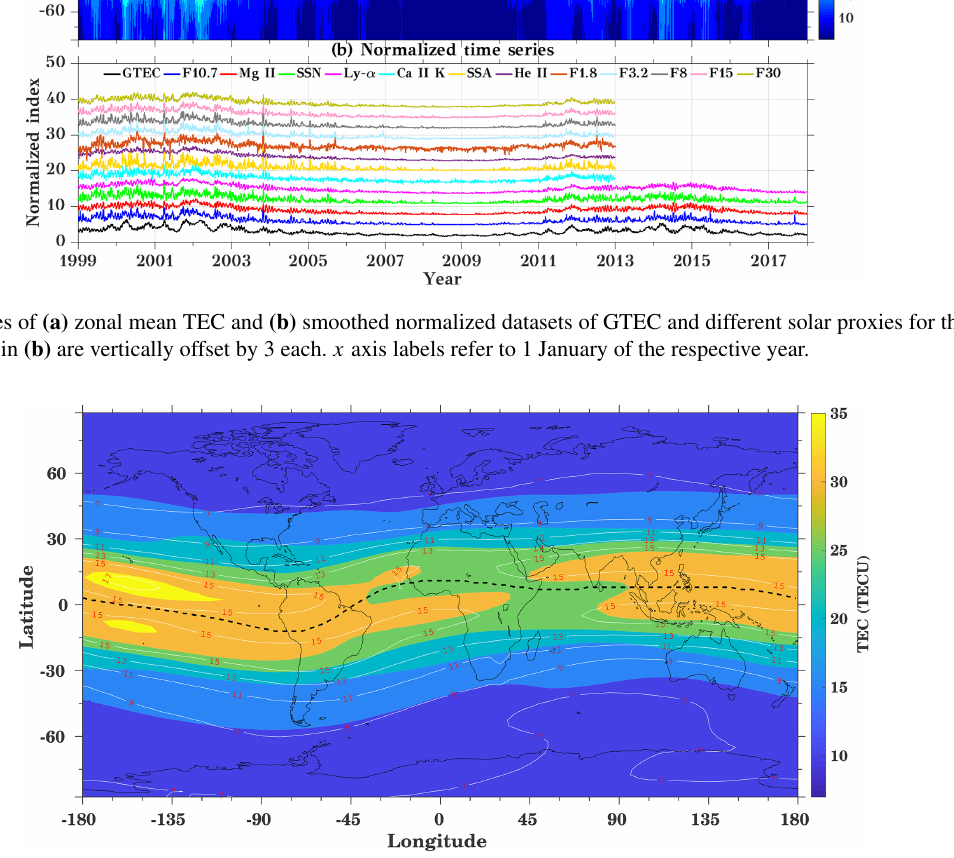
Figure 2. Long-term diurnal and annual mean TEC distribution during the years 1999 to 2017. The white contour lines indicate the standard deviation based on daily data. The black dashed line represents the magnetic